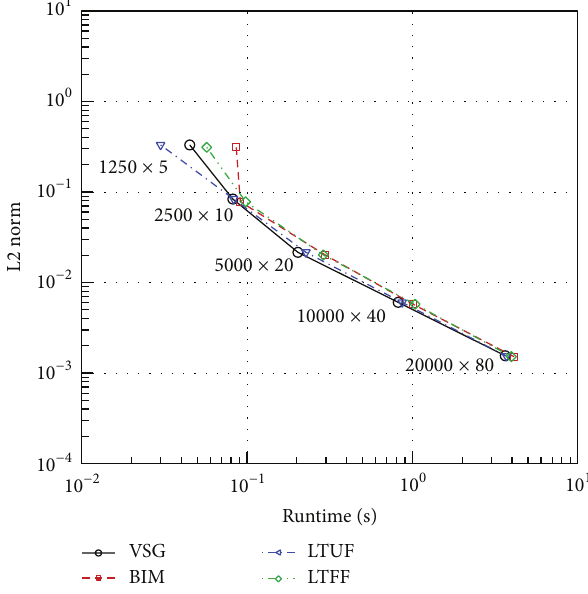
Figure 4: Comparison of L2 norm and runtime in the solution.